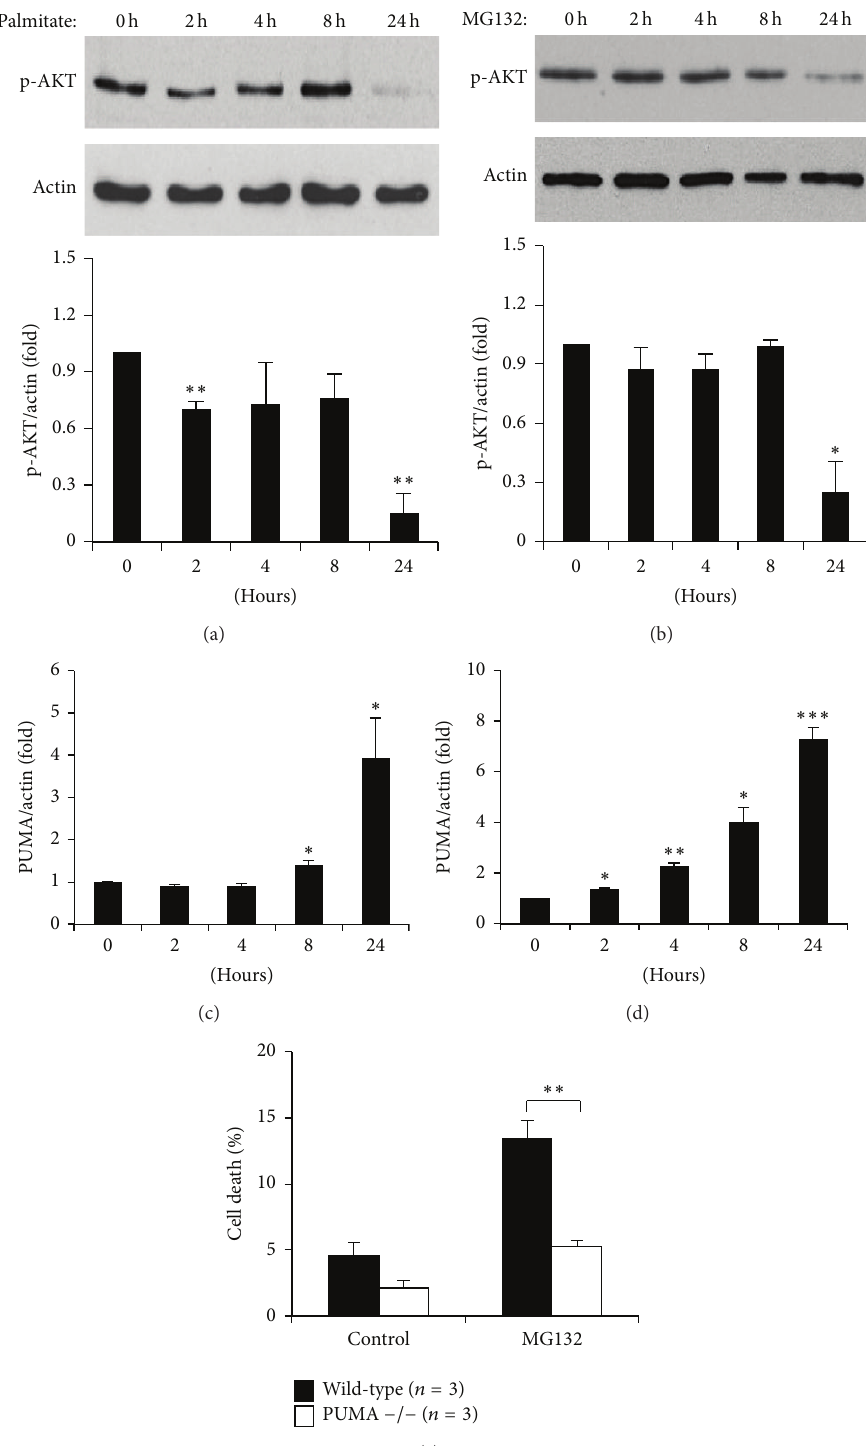
Figure 5: Palmitate and MG132 activate AKT and PUMA in pancreatic 𝛽 -cells. ((a)-(b)) MIN6 cells were treated with 0.5 mM palmitate (a) or 10 𝜇 M MG132 (b) as indicated and expression of p-AKT was measured by Western blot. Band intensities were quantified and values of the specific time points standardised to 𝛽 -actin loading controls. ((c)-(d)) MIN6 cells were treated with 0.5 mM palmitate (c) or 10 𝜇 M MG132 (d) and expression of PUMA was measured by qPCR. (e) Islets were obtained from wild-type C57BL/6 and PUMA −/− mice and treated with 10 𝜇 M MG132 for 24 h and subsequent levels of cell death were determined by FACS analysis. Results are the means ± SEM of 3–5 independent experiments. ∗ 𝑃 < 0.05 , ∗∗ 𝑃 < 0.01 , and ∗∗∗ 𝑃 < 0.001